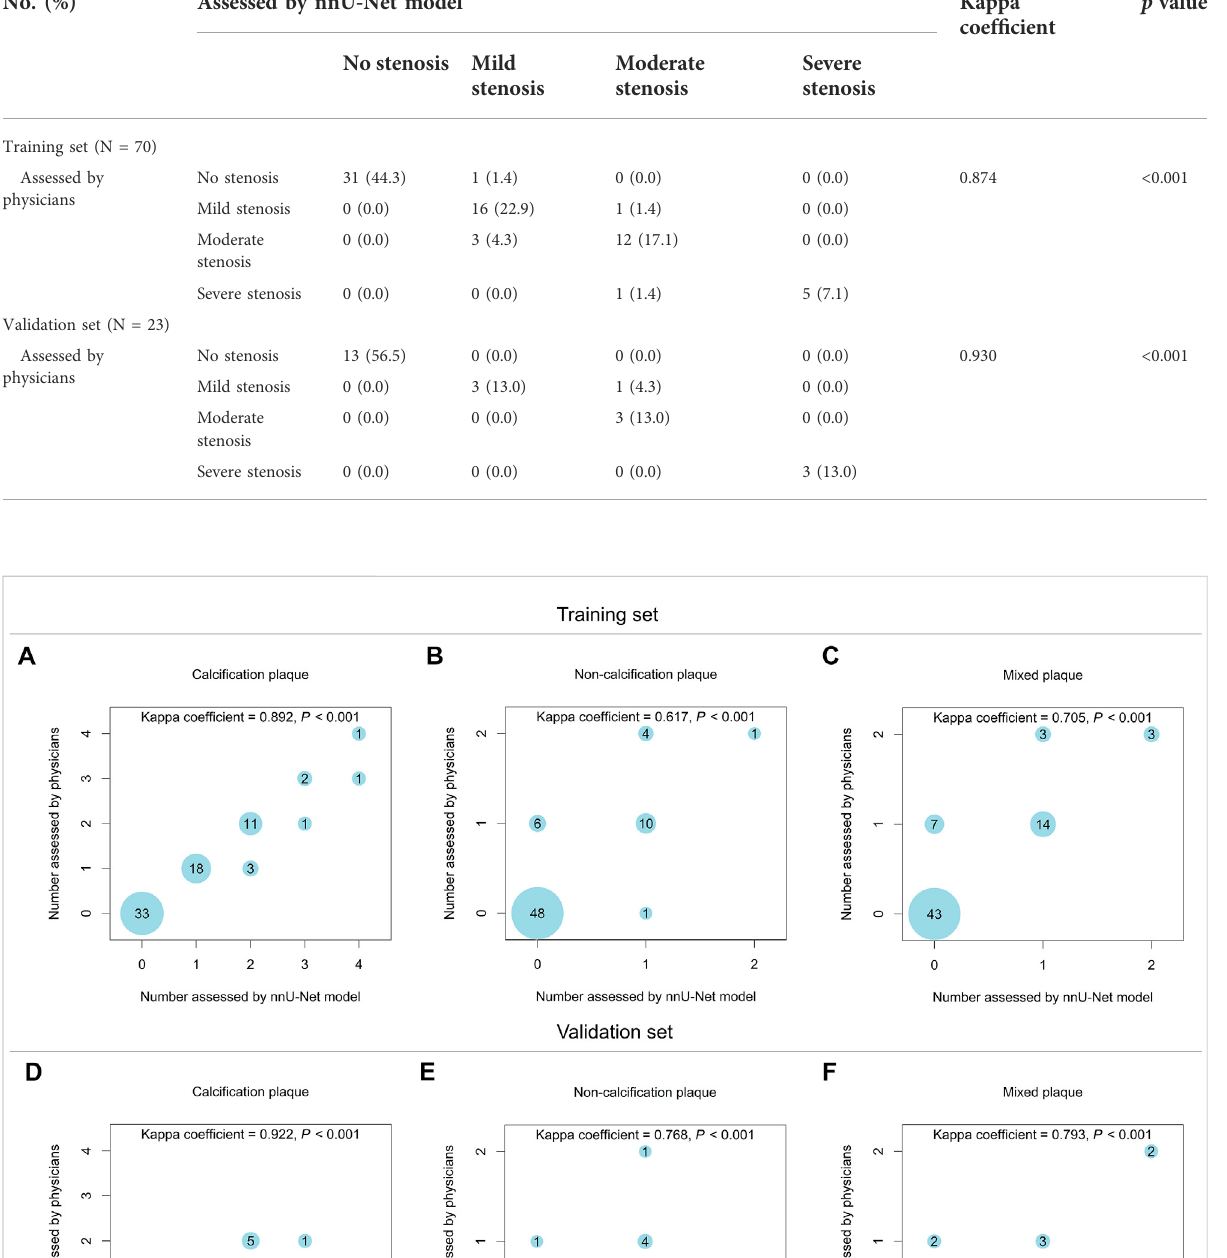
TABLE 4 Consistency between nnU-Net model and physicians in evaluating carotid artery stenosis degree in training and validation